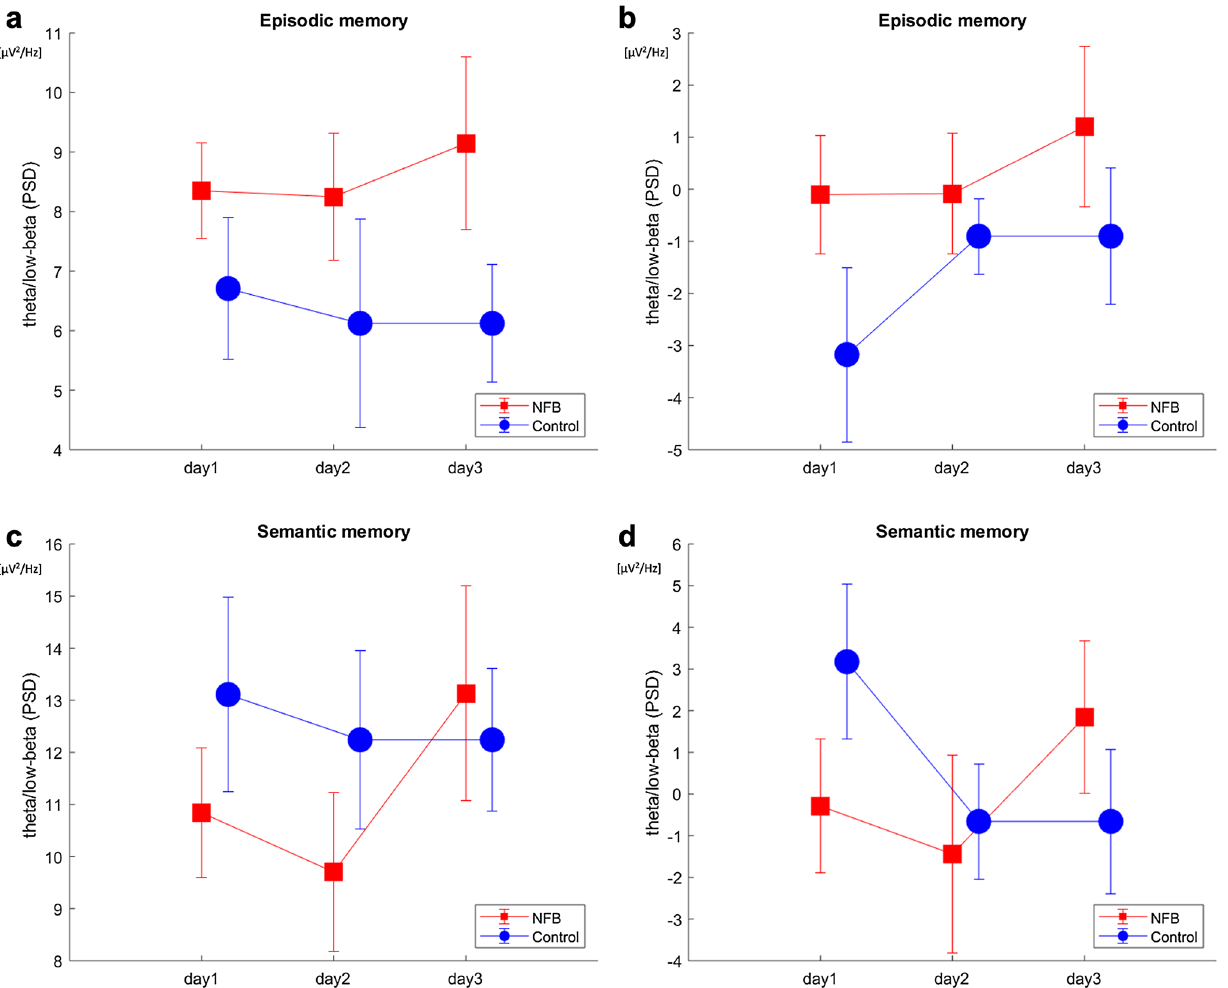
Figure 3. Power spectral density of theta/low-beta in the recall tests of episodic and semantic memories. ( a ): The average theta/low-beta power spectral density (PSD) during the third stage for episodic memory is shown. ( b ) : The average difference in the theta/low-beta PSD for episodic memory between the third and first stages (third stage – first stage) is shown. ( c ): The average theta/low-beta PSD in the third stage for semantic memory is shown. ( d ): The average difference in the theta/low-beta PSD for semantic memory between the third and first stages (third stage – first stage) is shown. The error bars represent ± 1 standard error of the mean. This figure was drawn using MATLAB